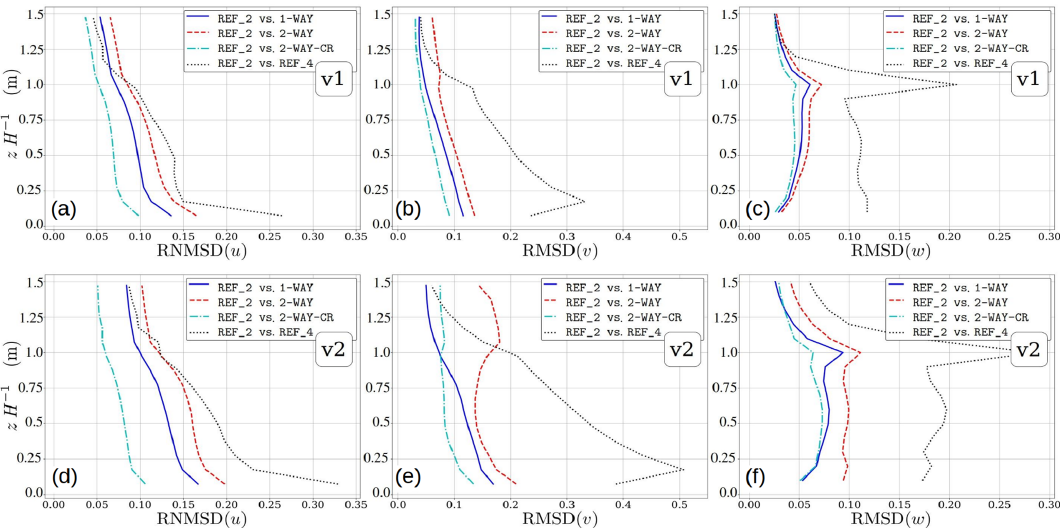
Figure 18. Vertical distributions of root-(normalized)-mean-square difference (RNMSD or RMSD) of velocity components for configuration v1 (a–c) and configuration v2 (d–f) . The metrics are evaluated for 15 horizontal planes in the range 0 ≤ z/H ≤ 1 . 5.